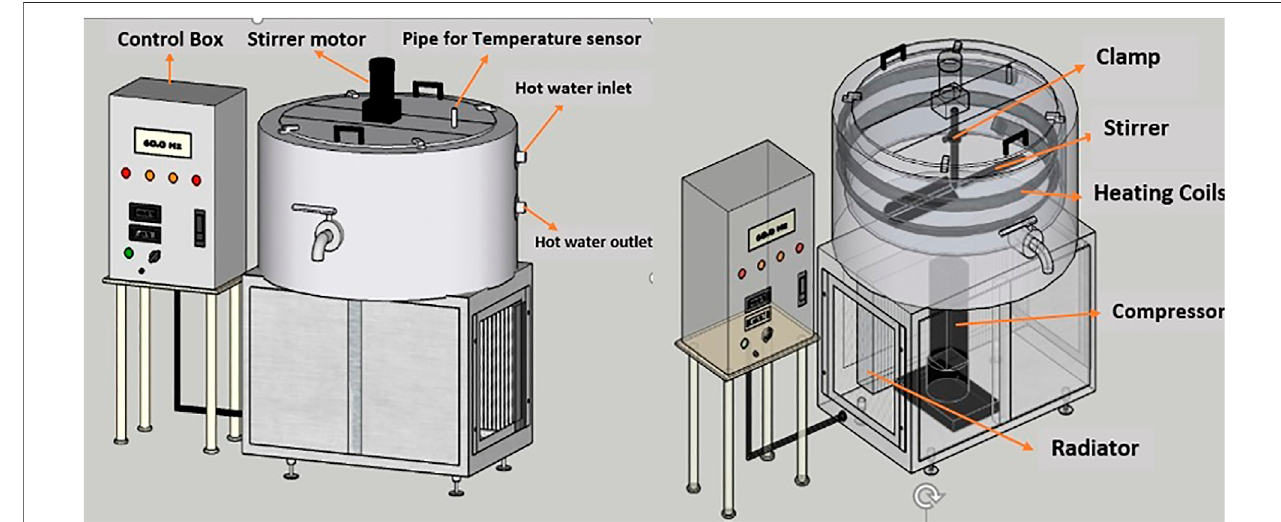
FIGURE 1 | Design of the solar assisted yogurt processing unit in CAD software.